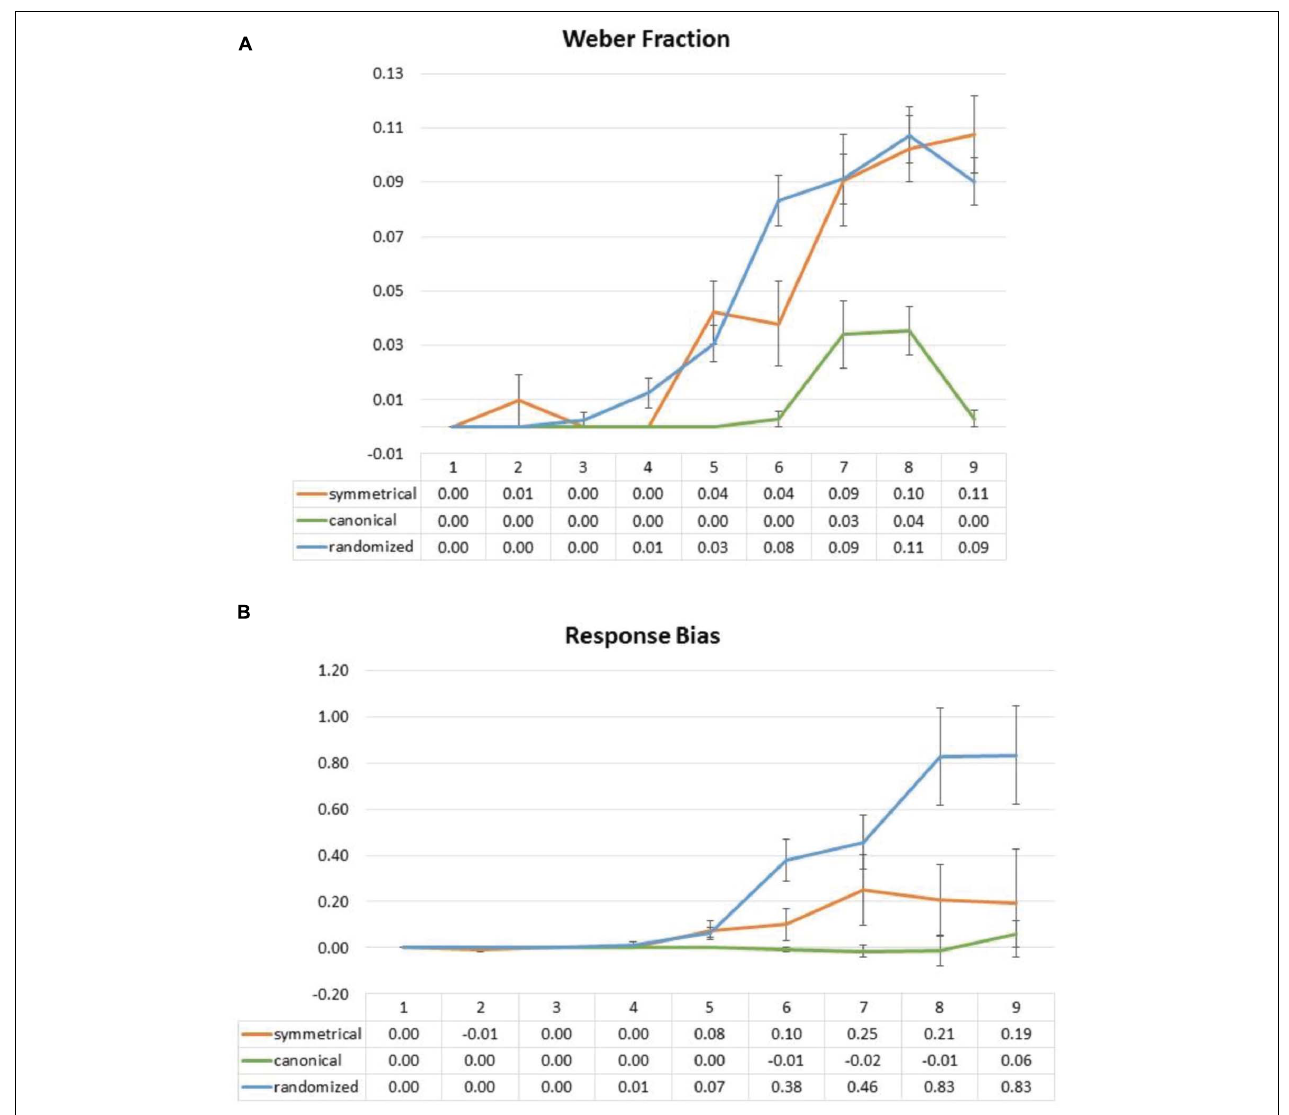
FIGURE 8 | Effect of symmetrical structure on Weber fraction (A) and response bias (B) in Experiment 2. Weber fraction data showed no significant interaction between the conditions. For response bias, there was no significance responses biases between canonical and symmetrical, but the randomized layout led to significant overestimation biases from set sizes 5 to